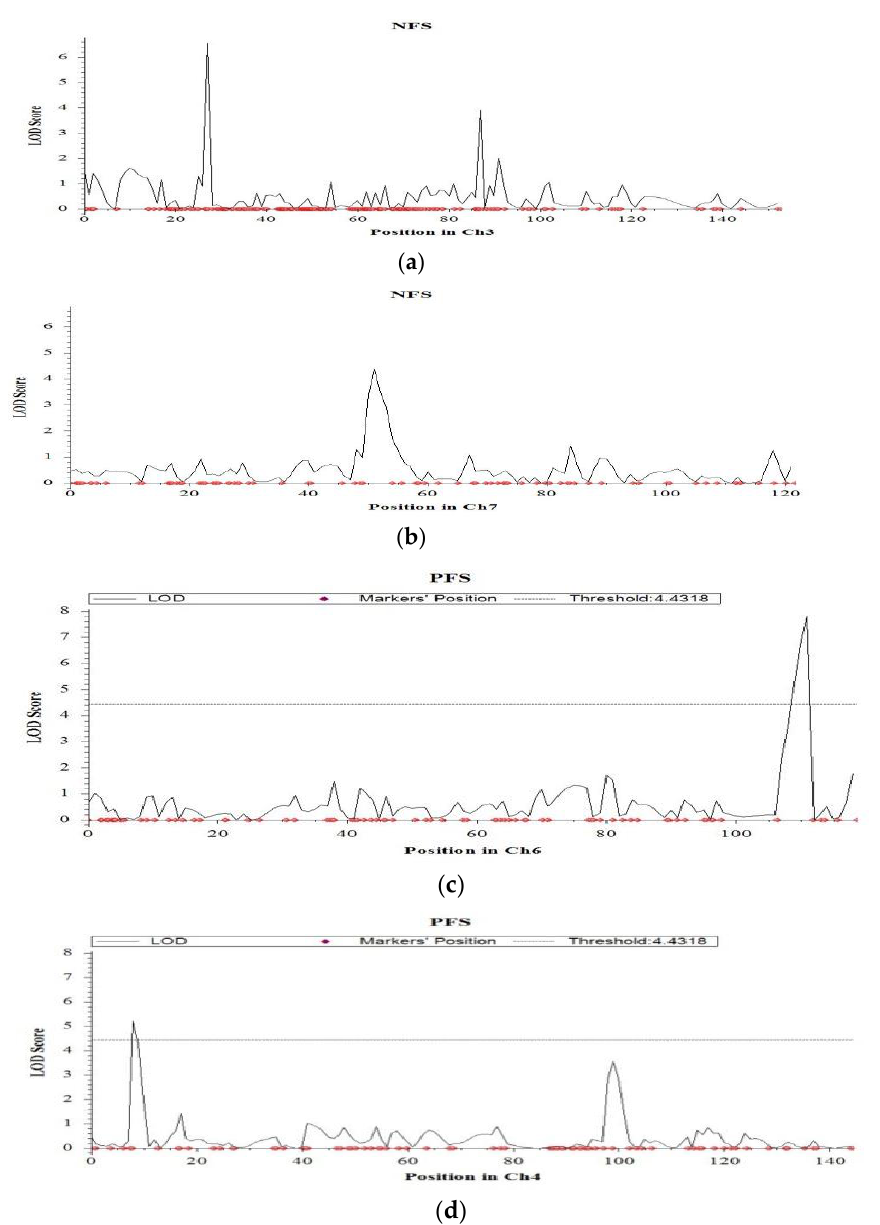
Figure 7. Chromosome locations of QTLs for number and percent filled spikelets under salinity stress based on a significant threshold of LOD 3.0 using ICIMapping on: ( a ) chromosome 3, ( b ) chromosome 7, ( c ) chromosome 6, and ( d ) chromosome 4. The horizontal line indicates the significant a LOD threshold at 95% confidence levels based on 1000 permutations.